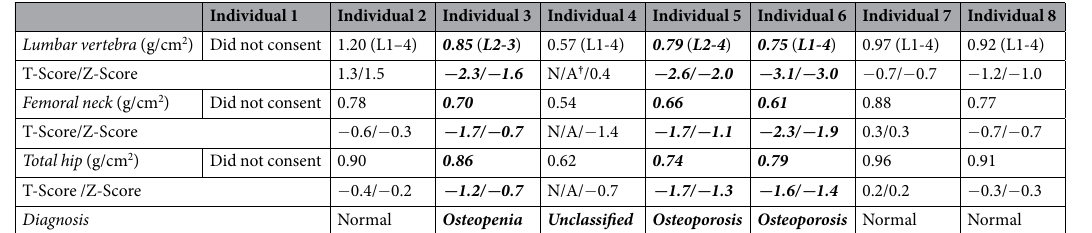
Table 4. Bone mineral density of individuals who are homozygous for p.Ser267Phe in SLC10A1 #,§ . # Figures that deviate from the normal range are in bold italics and are underlined. § Dual energy X-ray absorptiometry (DXA) measurements were made on a Discovery DXA System (Hologic Inc, Bedford, USA). The WHO criteria for classification in adults: Male age ≥ 50 or post-menopausal phase women: Normal: T-scroe ≥ –1.0,